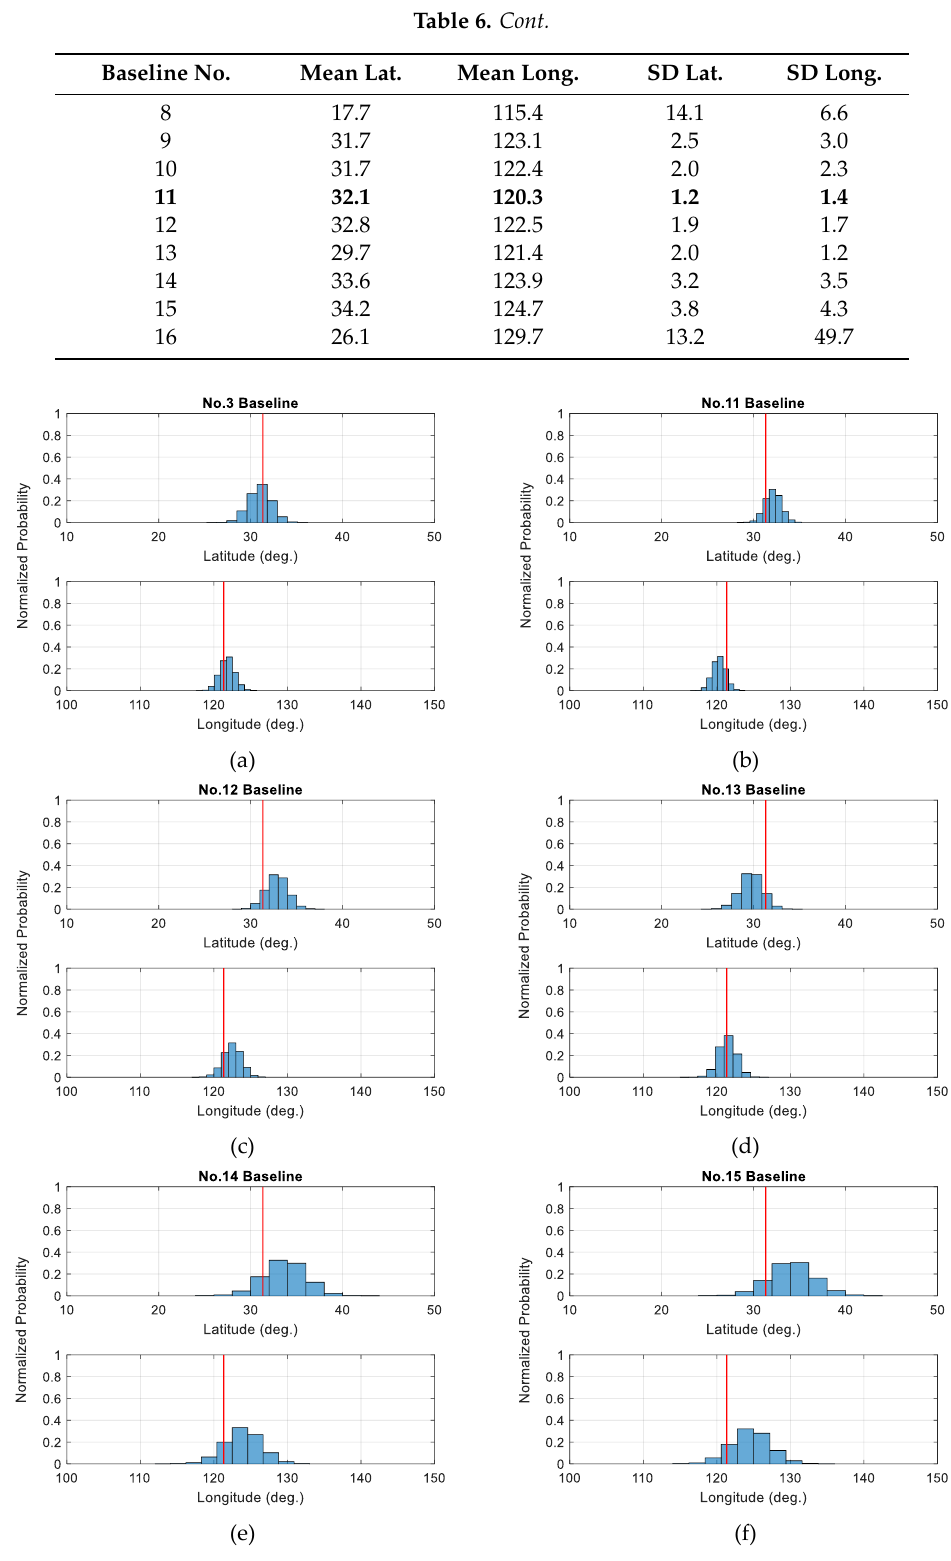
Figure 5. Statistical distribution of outlier direction estimates for site N006 related baselines. ( a ) for No.3 baseline, ( b ) for No.11 baseline, ( c ) for No.12 baseline, ( d ) for No.13 baseline, ( e ) for No.14 baseline and ( f ) for No.15 baseline (The red vertical lines stand for the latitude and longitude of site N006 ′ s antenna height direction.).